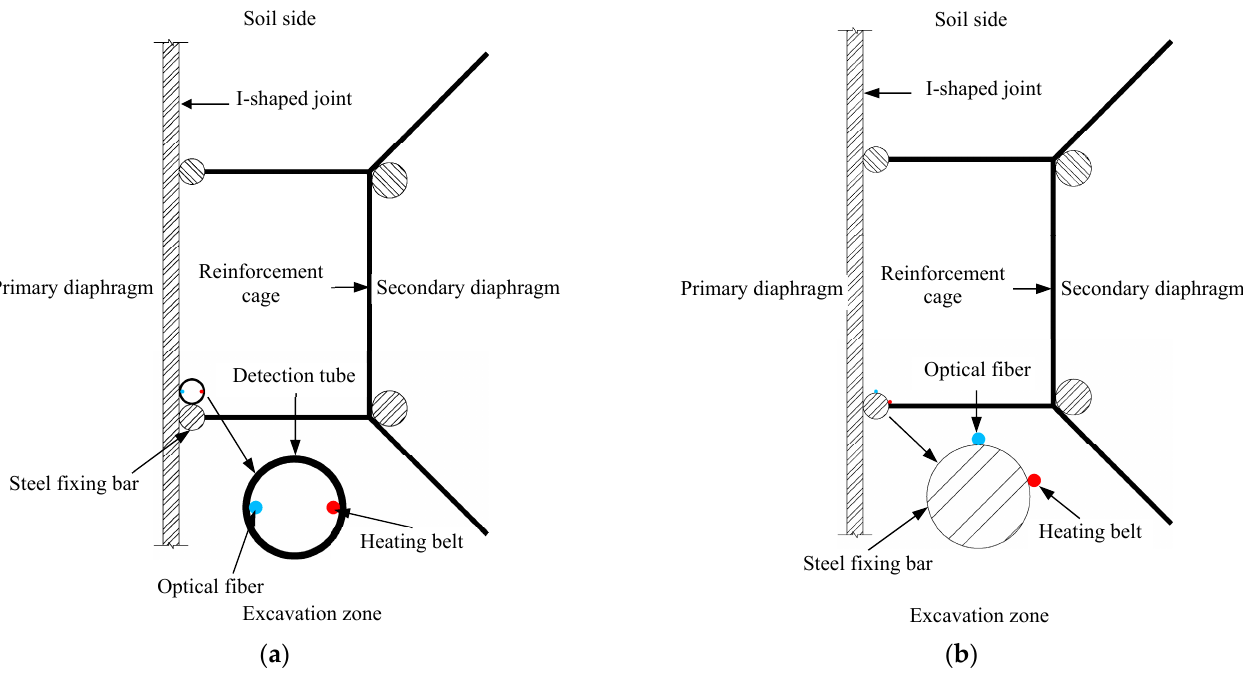
Figure 6. Top views of the test configurations considered in this work: ( a ) detection system incorporating a detection tube (i.e., schemes I; ( b ) tubeless detection system (scheme II).